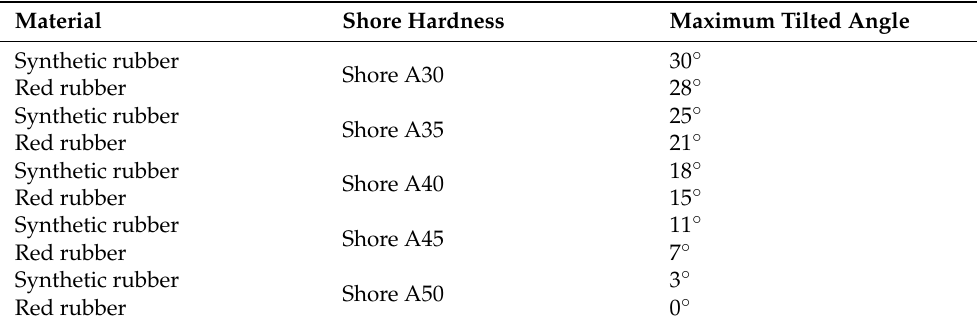
Figure 7. Relationship between adhesive coefficient and tilted angle . Table 2. Maximum value of tilted angle for each case of material and shore